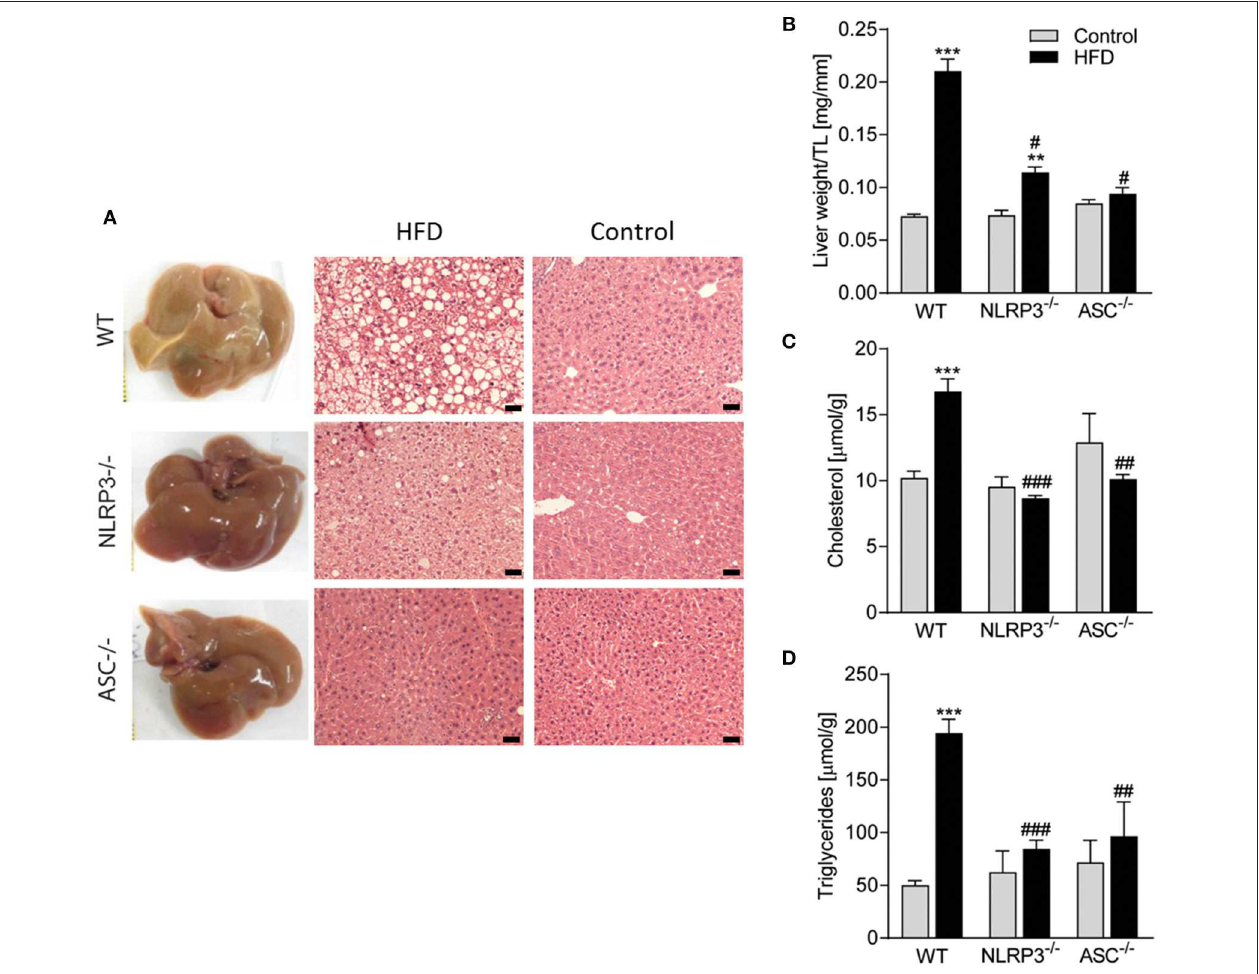
FIGURE 4 | Obesity-induced hepatic steatosis is suppressed by NLRP3 and ASC deficiency. WT, Nlrp3 − / − , and Asc − / − ( Pycard − / − ) male mice were exposed to high fat diet (HFD; 60 cal% fat) or a control diet for 52 weeks and liver was extirpated. (A) Representative images of livers and hematoxylin and eosin staining from mice on HFD and Control diet. Scale bar: 100 µ m. (B) Liver weights related to tibia length (TL). Hepatic levels of (C) cholesterol and (D) triglycerides. WT: Control, n = 10; HFD, n = 10, Nlrp3 − / − : Control, n = 7; HFD, n = 7, and Asc − / − ( Pycard − / − ): Control, n = 9; HFD, n = 5. Data are shown as mean ± SEM. ** P < 0.01, *** P < 0.001 vs. control diet; # P < 0.05, ## P < 0.01, ### P < 0.001 vs. WT-HFD as determined by two-way ANOVA and Tukey’s multiple comparisons